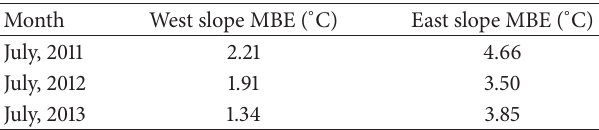
Table 1: Mean bias error between downscaled PRISM and the observations along the west and east slope of SNP in July 2011, 2012, and